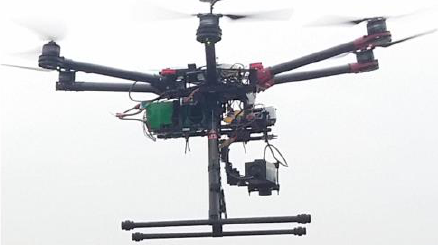
Figure 3: The UAV platform with the hyperspectral sensor on- board. Table 1: Bayspec OCI-F sensor specifications